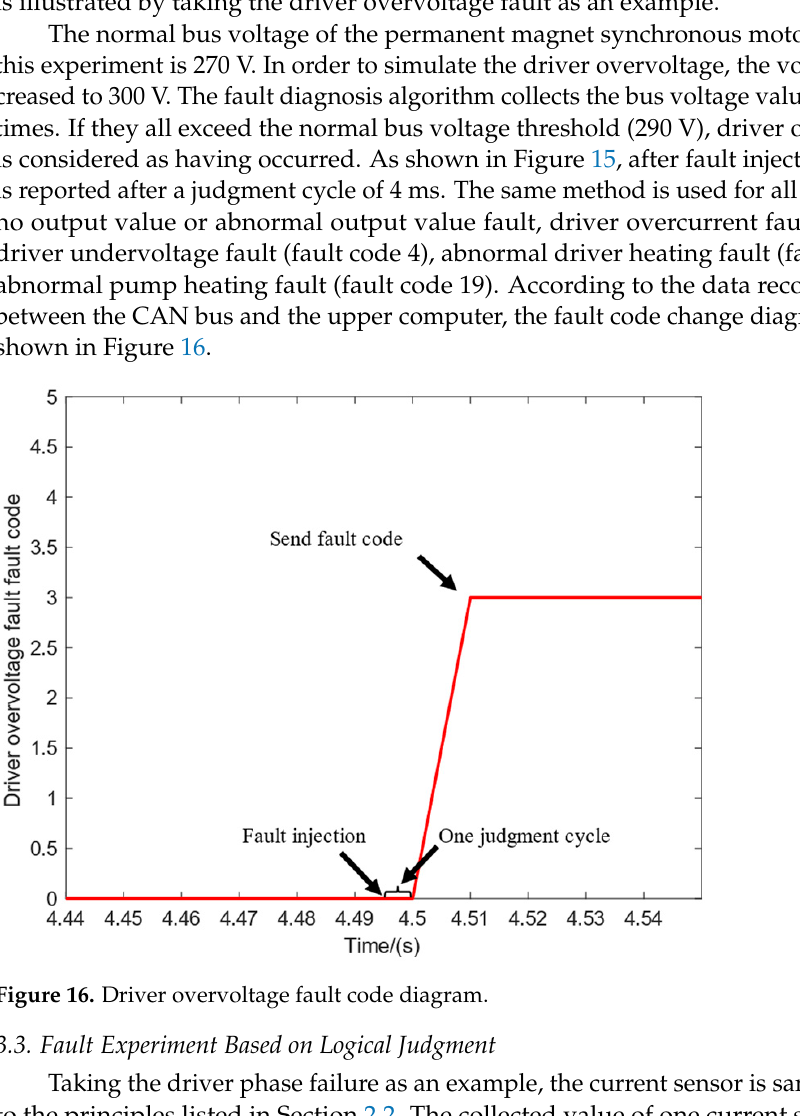
Figure 15. Testbench used for the fault injection experiments. ( a ) Load table test site; ( b ) Software and hardware debugging site.